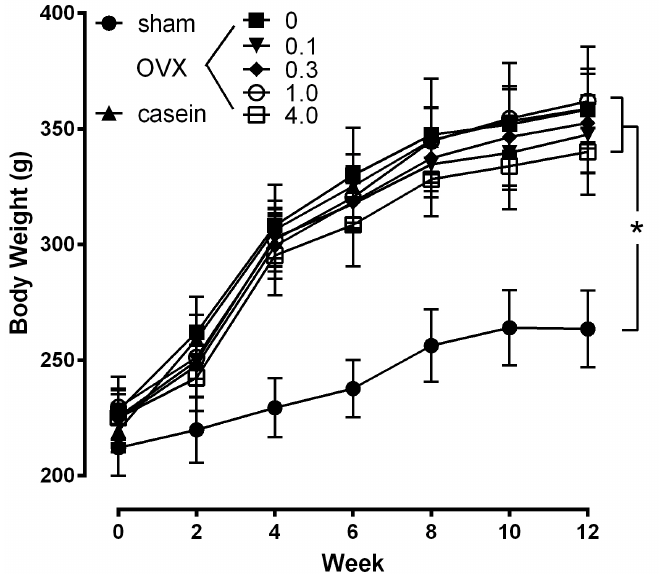
Figure 4. Effect of CH on body weight. The values represent the means ± SEM ( n = 12 per group). sham: sham operated group; OVX: ovariectomized group administrated with 0% − 4.0% CH; casein: OVX+casein (1%) group. * p < 0.05 vs. sham at the same time